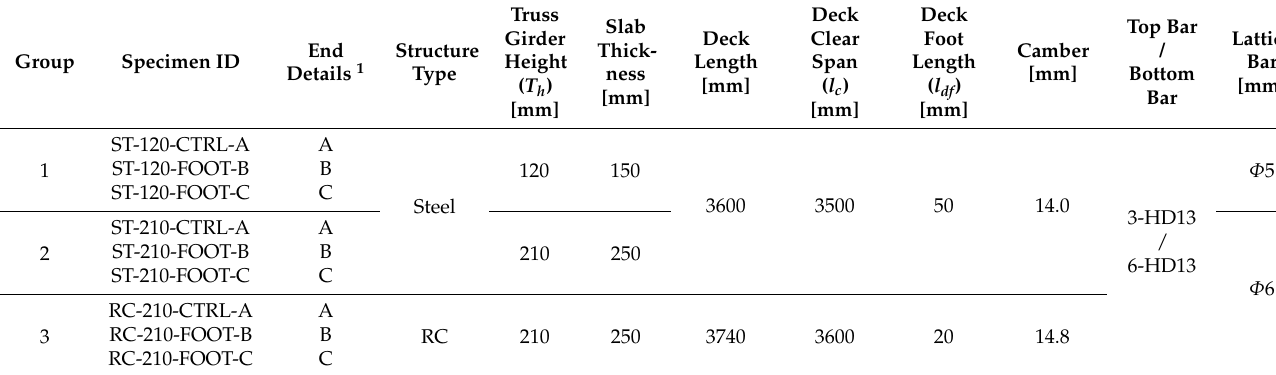
Figure 2. Details of each lattice truss girder (units in mm). ( a ) Section of wire-integrated steel deck plate. ( b ) Size details of wire-integrated steel deck plate. ( c ) Lattice truss girder of 120 mm. ( d ) Lattice truss girder of 210 mm.